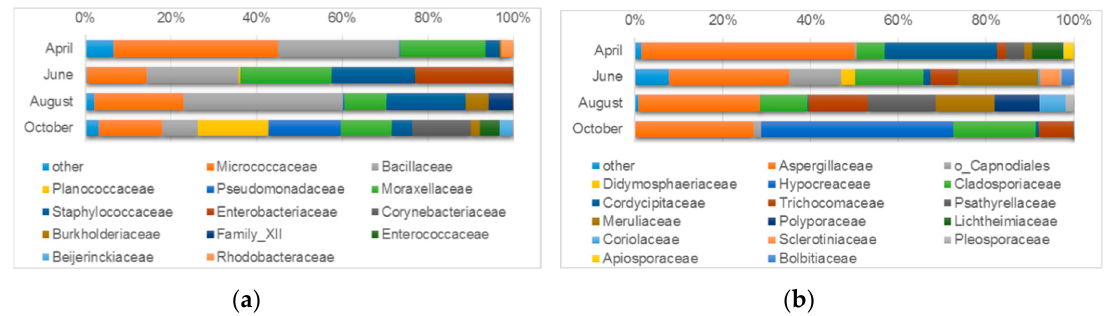
Figure 5. Microbial diversity of ancient walls based on deeply sequenced amplicons covering: ( a ) the bacterial V3V4 16S rDNA gene fragment and ( b ) the fungal ITS2 (internal transcribed spacer 2) region. The bar chart shows by default the relative abundance of families with an abundance greater than 2% in at least one variant. Sequences that were not assigned at the family level were named in accordance with the lowest available taxonomy: o - order, c - class.